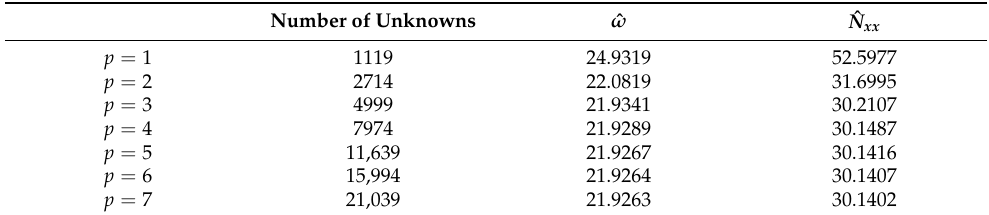
Table 6. Nondimensional frequency ˆ ω and buckling load ˆ N xx for a SSSS anisotropic plate using a uniform ps − refinement